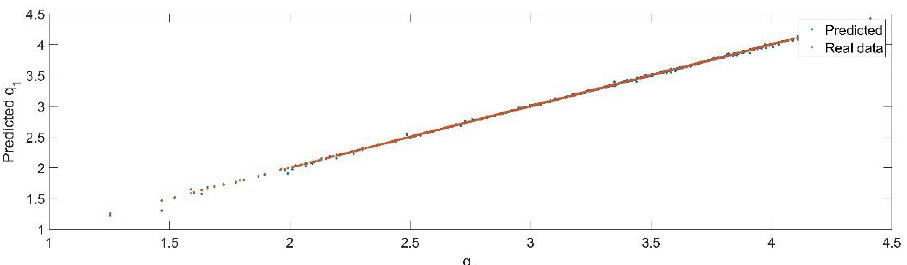
Figure 8. The comparison between the real data (the real value of q 1 ) and the predicted data (the predicted value of q 1 ).